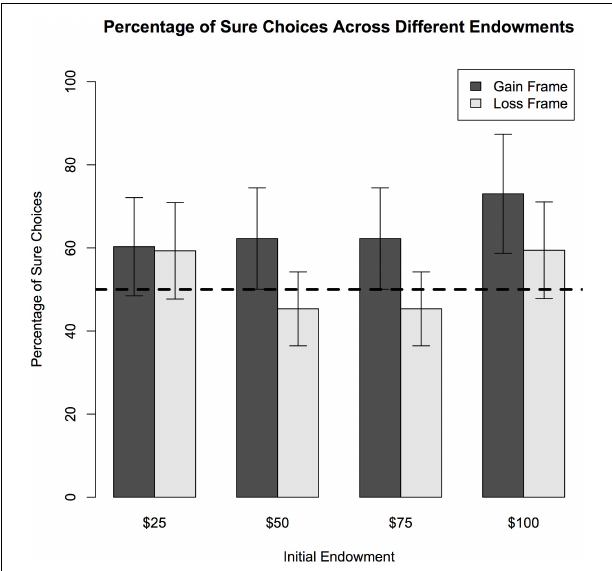
FIGURE 2 | Behavioral results of decisions across varying endowments. The plot shows the percentages of trials in which subjects chose the sure option in the gain and loss frames for four different starting amounts. In a 2 × 4 (frame-by-initial amount) ANOVA analysis revealed a main effect of frame [ F (2,193 = 17.31, p < 0.001]. Participants demonstrated risk-aversion (i.e., choosing the sure option) more frequently as the initial endowment increased. Increased age predicted higher sure choices only in the $100 endowment category [ F (4,193) = 2.70, p = 0.008] but did not predict choices in the other endowments. Also, a main effect of endowment amounts [ F (4,193) = 22.57, p < 0.001] demonstrated that participants had the highest framing effects in the $50 and $100 categories. The effect of initial endowment on sure choices was significantly greater in the gain frame than in the loss frame (the interaction of frame-by-initial amount) [ F (3,193) = 2.28, p = 0.025].